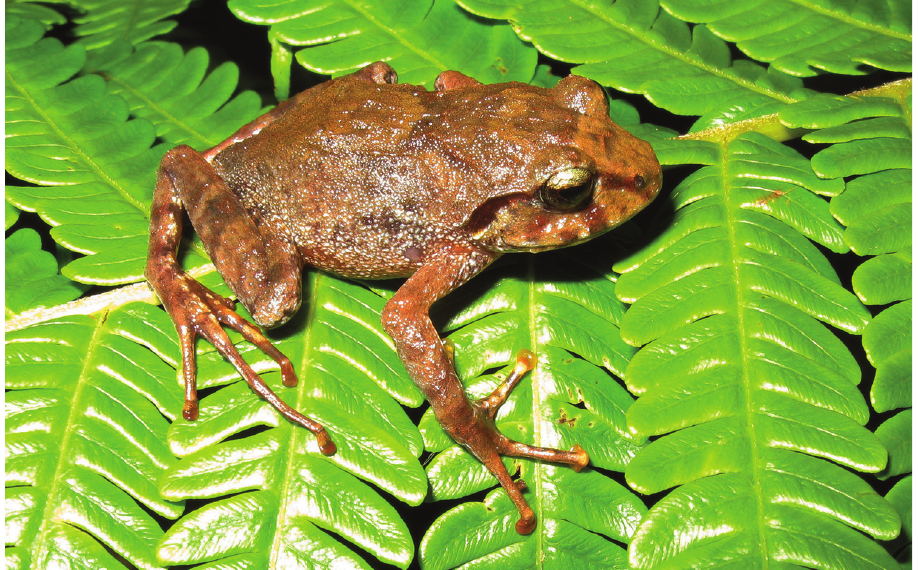
Figure 11. Platymantis sp. “Dual” male (specimen deposited in PNM) from Mt. Balatukan, Municipal- ity of Gingoog, Misamis Oriental Province. Photo: